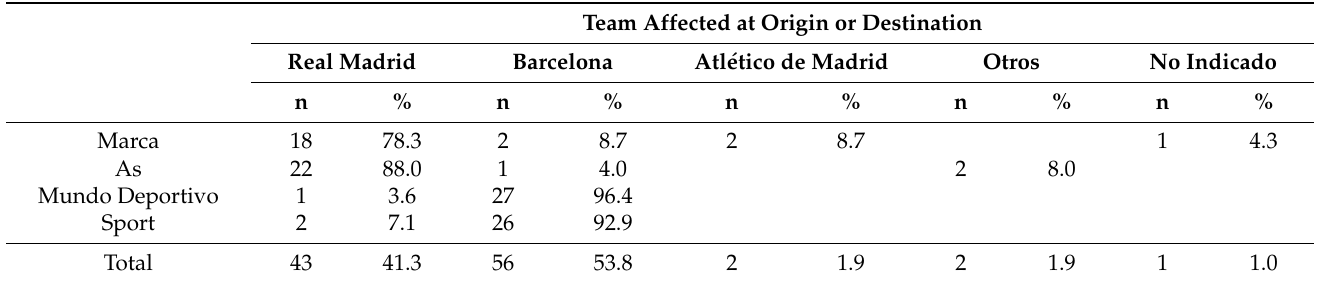
Table 7. Team affected by the signing, depending upon newspaper. Compiled by author.